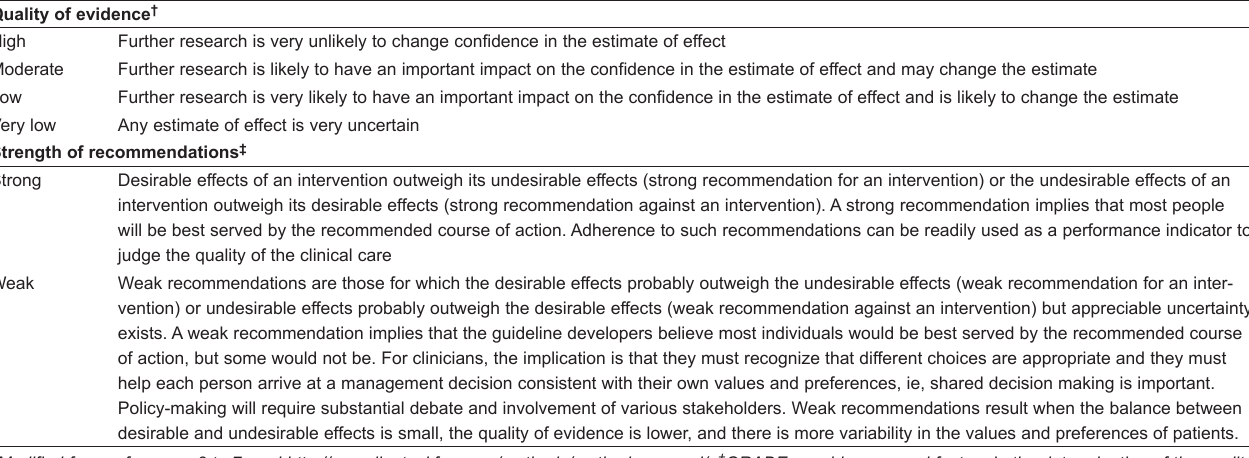
TAble 1 Grading of Recommendations Assessment, Development and evaluation (GRADe) rating of evidence and strength